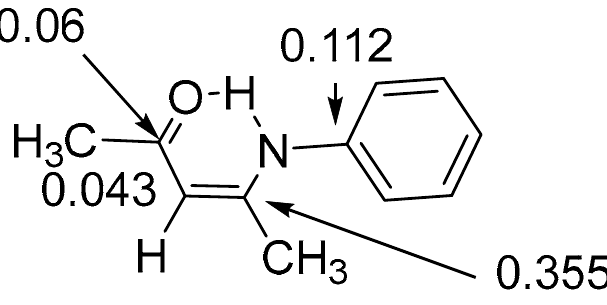
Figure 18. Deuterium isotope effects on 13 C chemical shifts in ppm. Taken from Ref. [12]. Isotope effects have often been plotted vs. XH chemical shifts. [75] In the present case, two-bond deuterium isotope effects (TBDIE) are plotted vs. NH chemical shifts (Figure 19). It is clear that E - and Z -derivatives can be distinguished. The correlation covers enaminones, nitro- and sulphinyl derivatives [32].